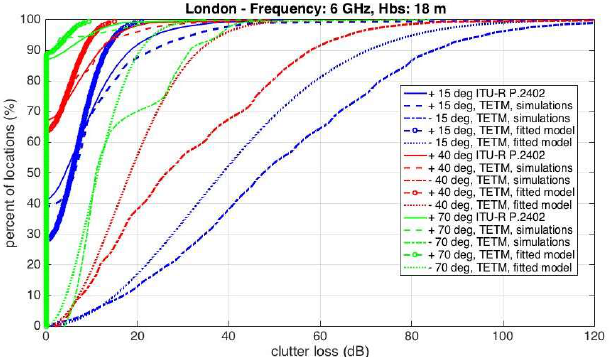
Figure 13. Clutter loss cumulative distributions: comparison between the proposed model and the ITU-R P.2402 model, for elevation angles of 15, 40 and 70 degrees in London (base station height fixed at 18 m).